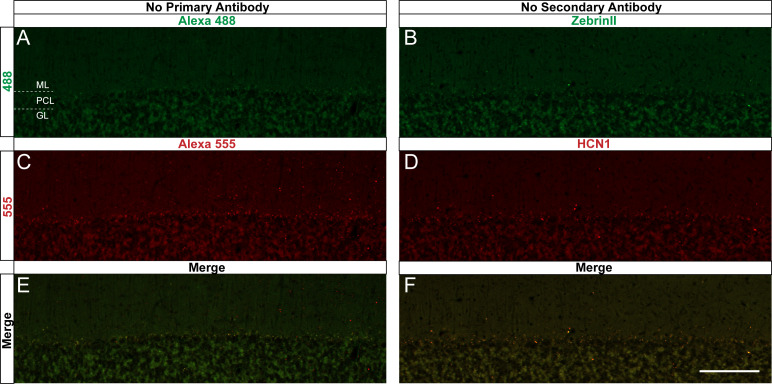
Sample antibody staining controls for the expression of protein markers in basket cell zones.(A, C, E) Secondary antibody staining without the application of a primary antibody shows only the expected background, non-specific signal that is typical for Alexa 488 (green), Alexa 555 (red), and merged images, respectively. (B, D, F) Primary antibody staining without the application of secondary antibody also shows the lack of an immunopositive signal for zebrinII (green), HCN1 (red) and merged images, respectively. Scale bar in F is 100 μm. (A, B) were imaged to visualize the Alexa 488 fluorophore; (C, D) were imaged to visualize the Alexa 555 fluorophore (N = 7).